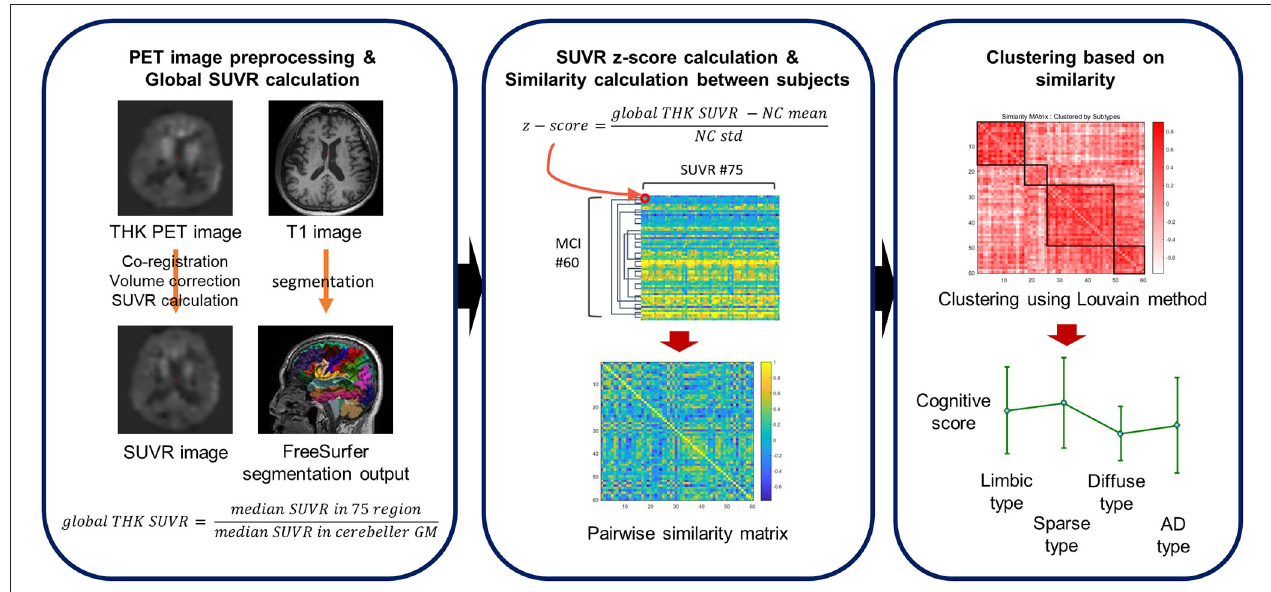
FIGURE 1 | A schematic overview of the clustering pipeline. Z-scores are computed for each subject’s THK SUVR with respect to the cognitively normal (CN) subjects. The similarity of any pair of subjects is defined using a correlation coefficient between regional THK SUVR levels of the subjects.